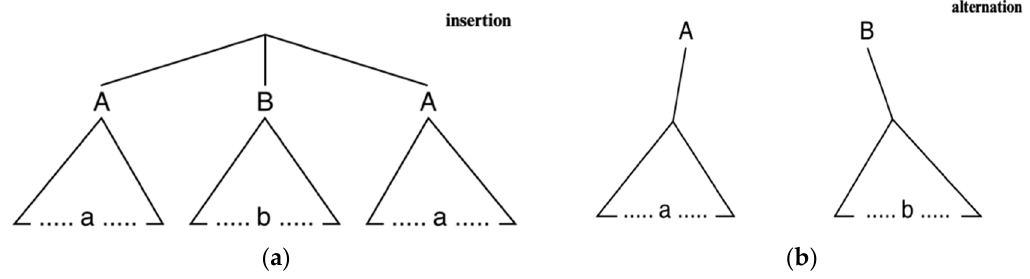
Figure 1. ( a ) Insertion and ( b ) Alternation (Muysken 2000, p. 7). Example